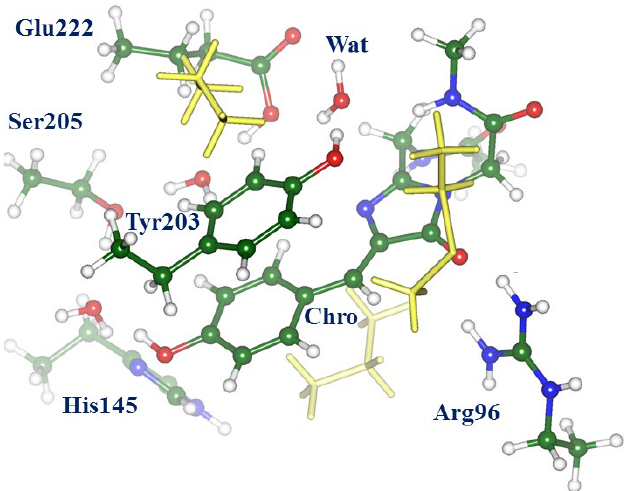
Figure 2. Composition of the molecular cluster mimicking the chromophore-containing pocket in Dreiklang in the configuration of the ON-state. Colored balls and sticks distinguish molecular groups, which are essential for the mechanism of the light-induced chromophore hydration reaction. Yellow sticks indicate molecular groups besides the key reaction participants, which are included in the system to surround atoms in the active site.